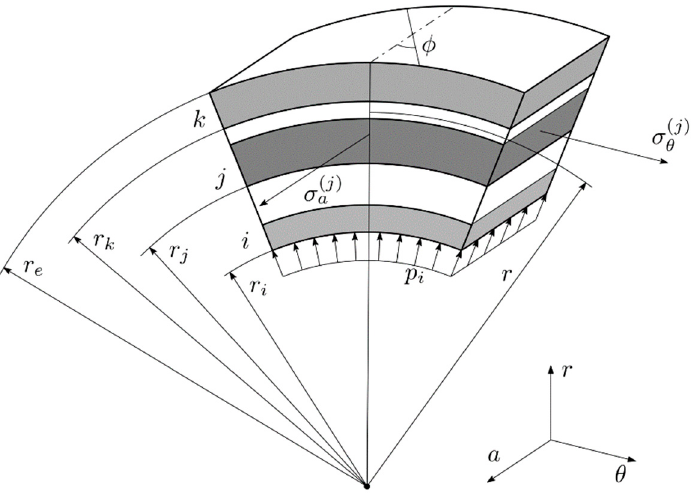
Figure 2. The cylindrical coordinate system nomenclature.